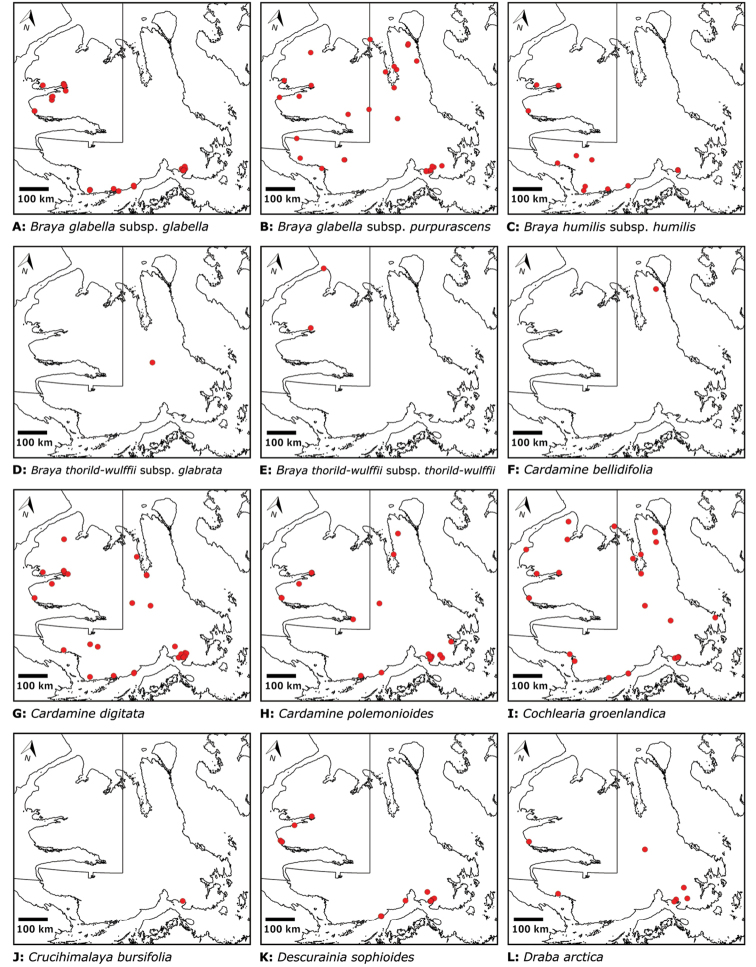
Species distribution maps. Brassicaceae: ABraya
glabella
subsp.
glabellaBBraya
glabella
subsp.
purpurascensCBraya
humilis
subsp.
humilisDBraya
thorild-wulffii
subsp.
glabrataEBraya
thorild-wulffii
subsp.
thorild-wulffiiFCardamine
bellidifoliaGCardamine
digitataHCardamine
polemonioidesICochlearia
groenlandicaJCrucihimalaya
bursifoliaKDescurainia
sophioidesLDraba
arctica.